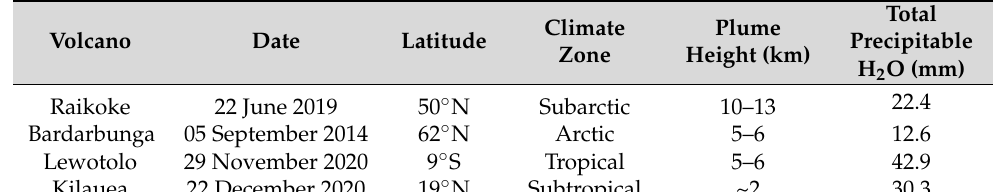
Table 1. Summary of the test cases.